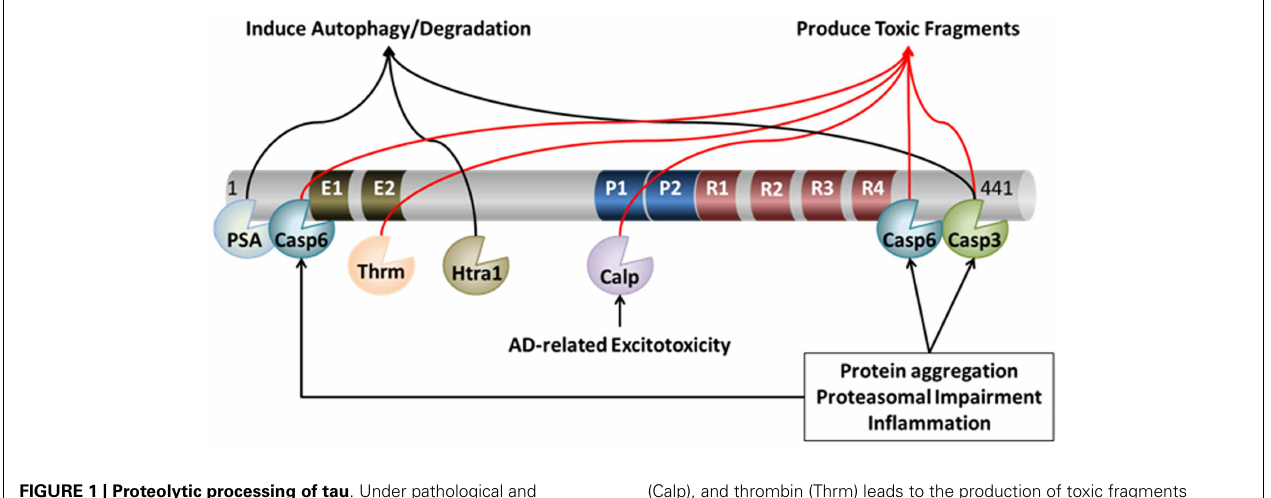
FIGURE 1 | Proteolytic processing of tau . Under pathological and physiological conditions, tau undergoes cleavage at many distinct proteolytic sites by a myriad of proteases.The action of these proteases can lead to both protection and/or exacerbation of pathology. For example, cleavage of tau by caspase (Casp) 3, caspase-6, calpain